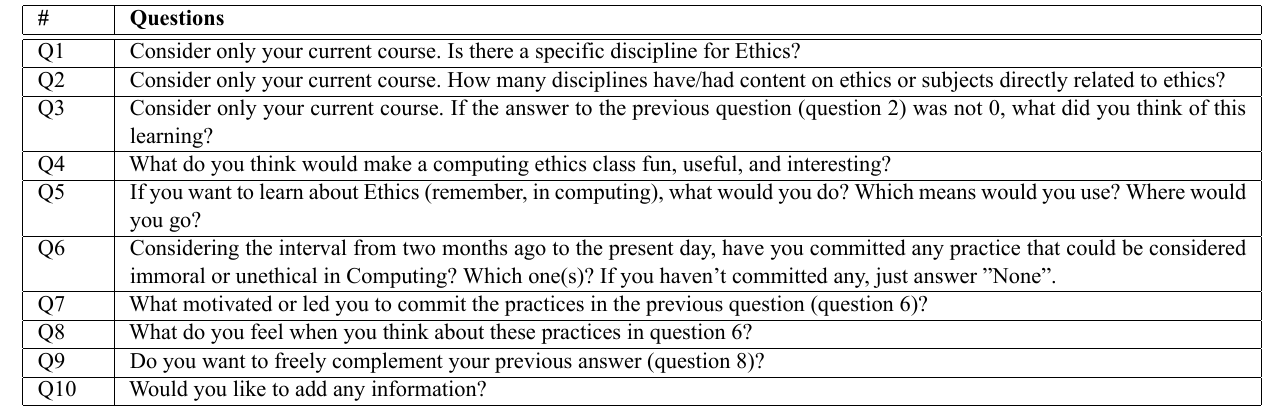
Table 2. Research sub-questions and